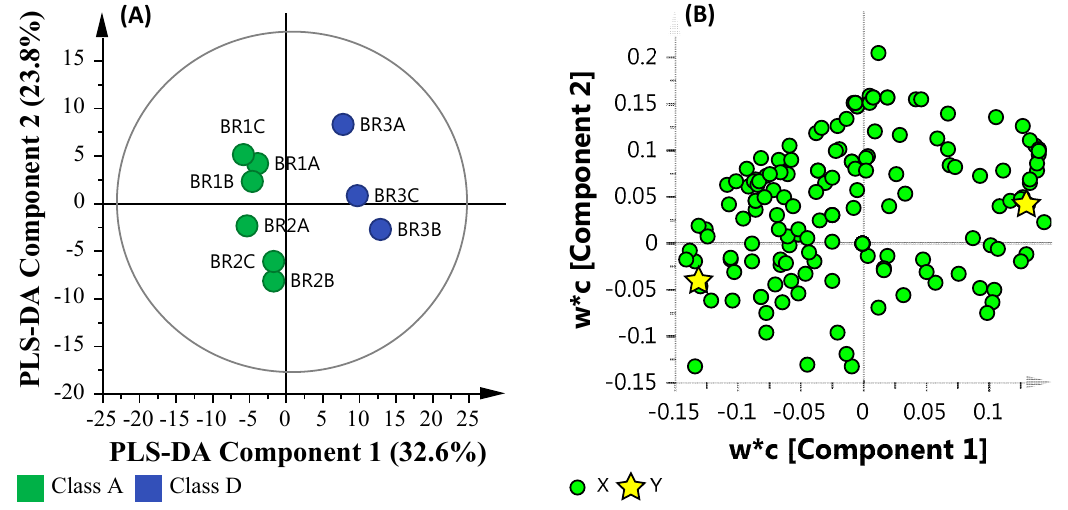
Figure 8. PLS-DA plot of the metadata and multi-omics datasets based the Microbial Water Quality Assessment Category class and low salinity assessment. ( A ) PLS-DA Score Scatter plot; ( B ) PLS-DA Loading Scatter plot.